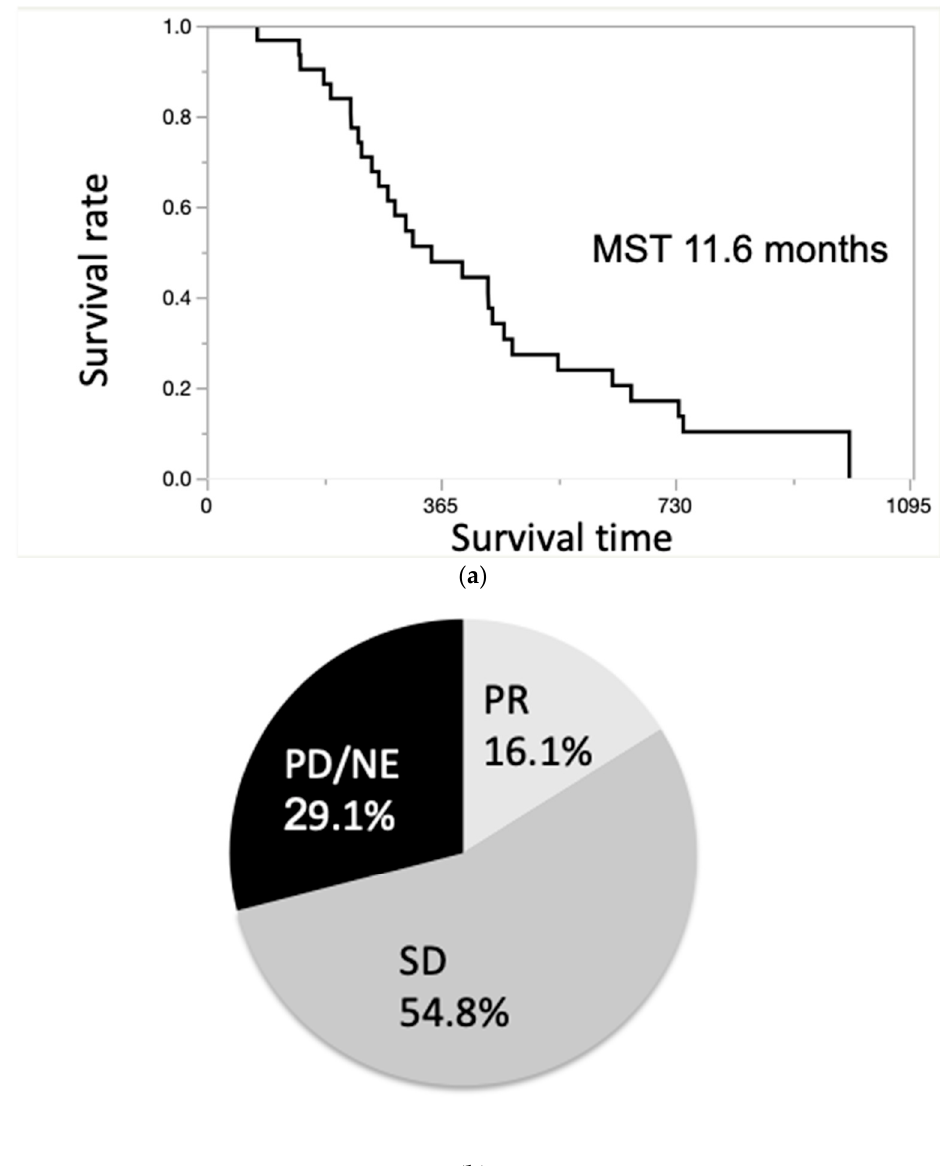
Figure 3. ( a ). Overall survival curve of patients with unresectable ICC. The median survival time (MST) of all the patients was 11.6 months. ( b ). Treatment effect evaluated by Response Evaluation Criteria in Solid Tumors (RECIST). The response rate (RR) was 16.1%, and the disease control rate (DCR) was 70.9%.